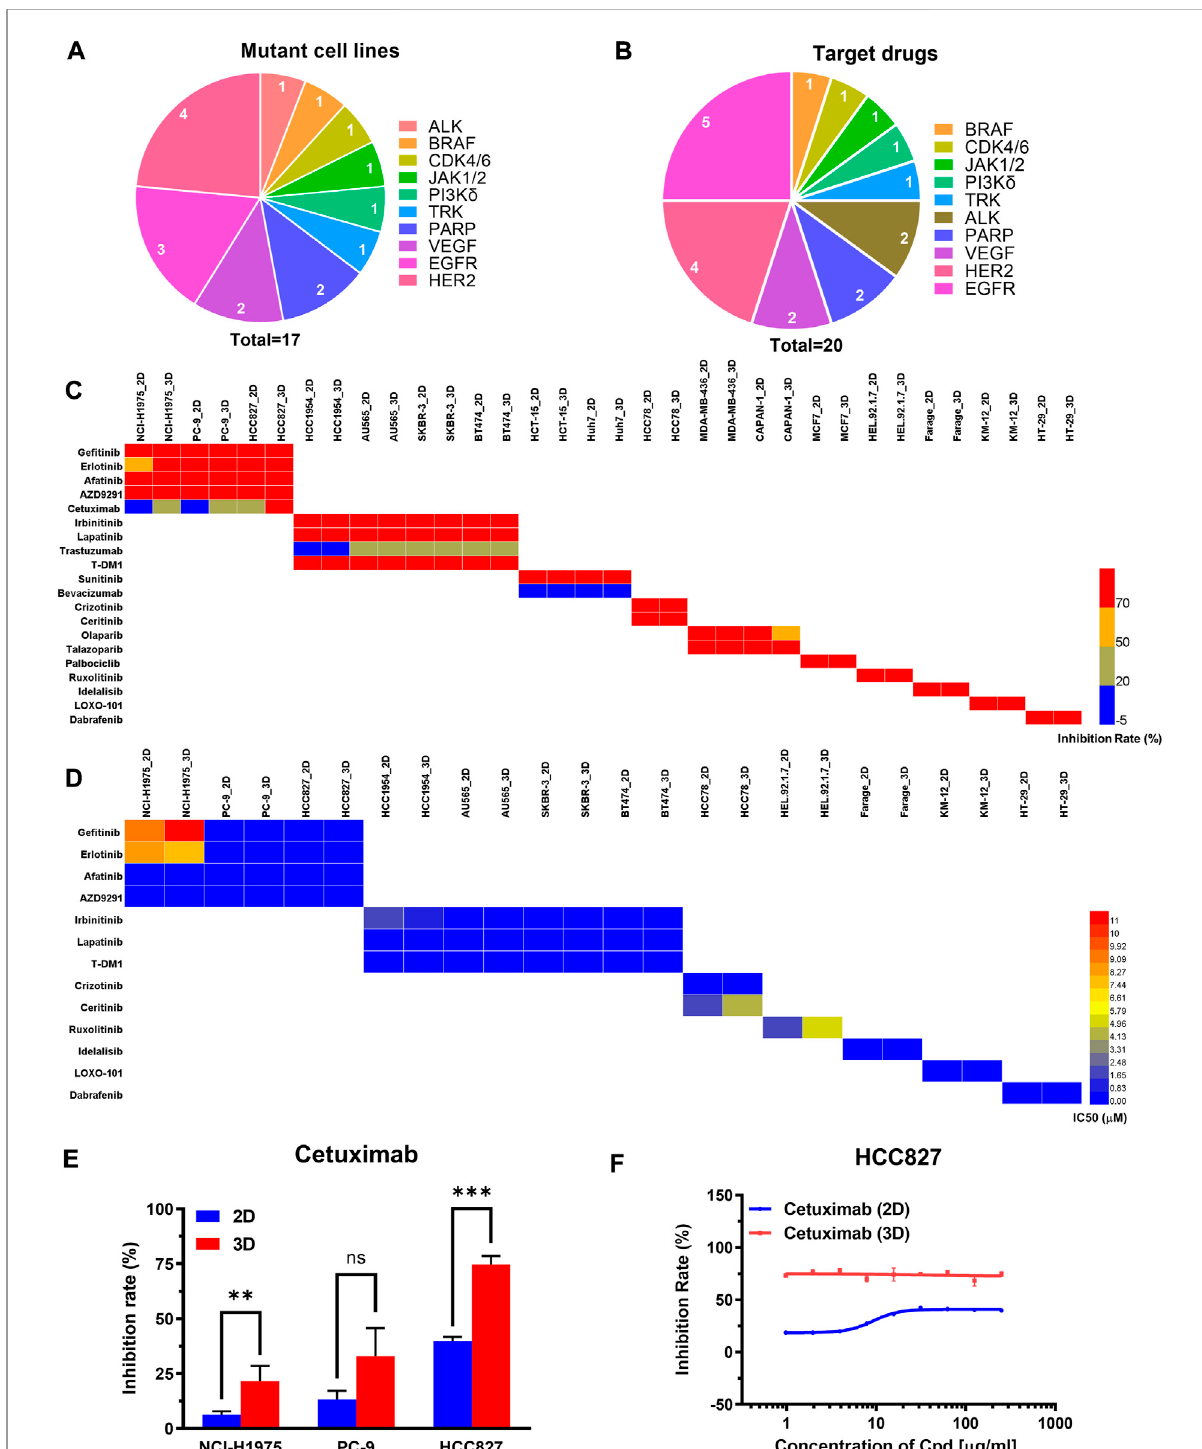
FIGURE 5 Thecomparisonofprimaryandsecondaryevaluationoftargeteddrugsbetweenthepaired2Dand3Dmodels. (A) Schematicsofdistributionof the human cancer cell lines with different mutant genes in this study. (B) Schematics of distribution of targeted drugs with different mutant genes in this study. (C) Heat map of inhibition rates of the drugs on the 2D and 3D models from the primary evaluation. Red color represents higher inhibition rate with stronger ef fi cacy, whereas blue color represents lower inhibition rate with poorer ef fi cacy. Blank boxes in the heat map indicates no test. (D) Heatmap of theIC 50 valuesof thedrugs on the 2D and 3Dmodelsfrom the secondary evaluation. The IC 50 valueswere calculated from